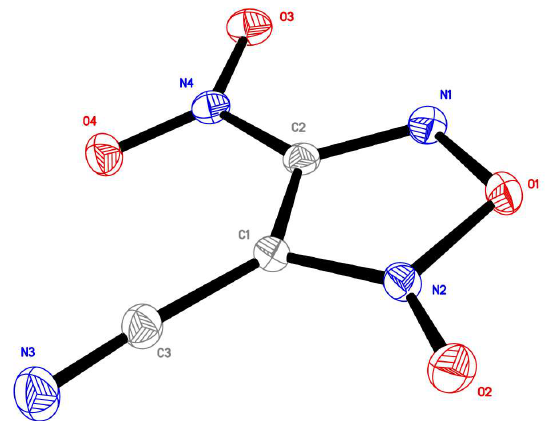
Figure 1. The crystal structure of 3-cyano-4-nitrofuroxan 12 . All atoms are shown as probability ellipsoids of atomic displacements ( p = 50%).